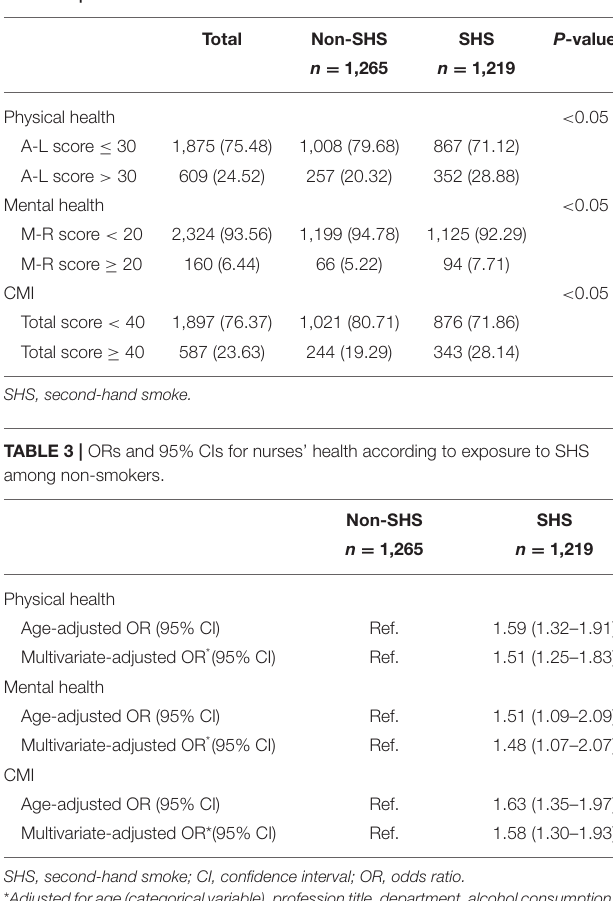
TABLE 2 | Association between SHS and health